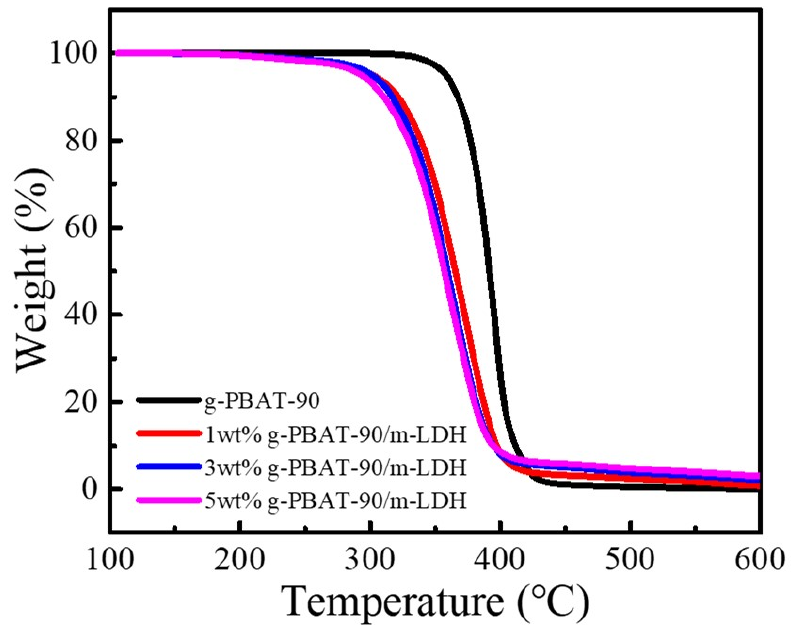
Figure 7. TGA profiles of g-PBAT-90 and various weight ratios of g-PBAT-90/m-LDH nanocomposites. Table 2. Thermal degradation temperatures at 10% and 50% weight losses and storage modulus in